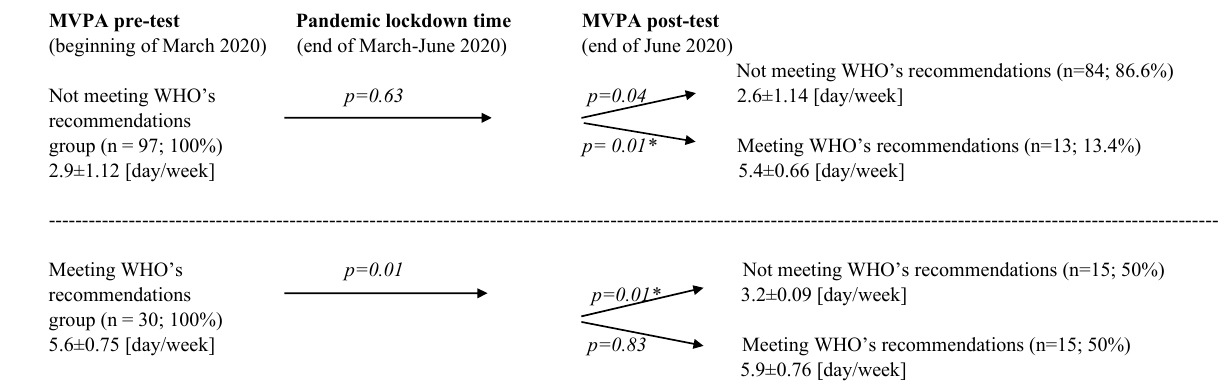
Figure 2. Comparison in meeting WHO’s recommendations for MVPA (days/week) between pandemic pre- and post-test differentiation (M ± SD) within the youth groups. * p < 0.05.